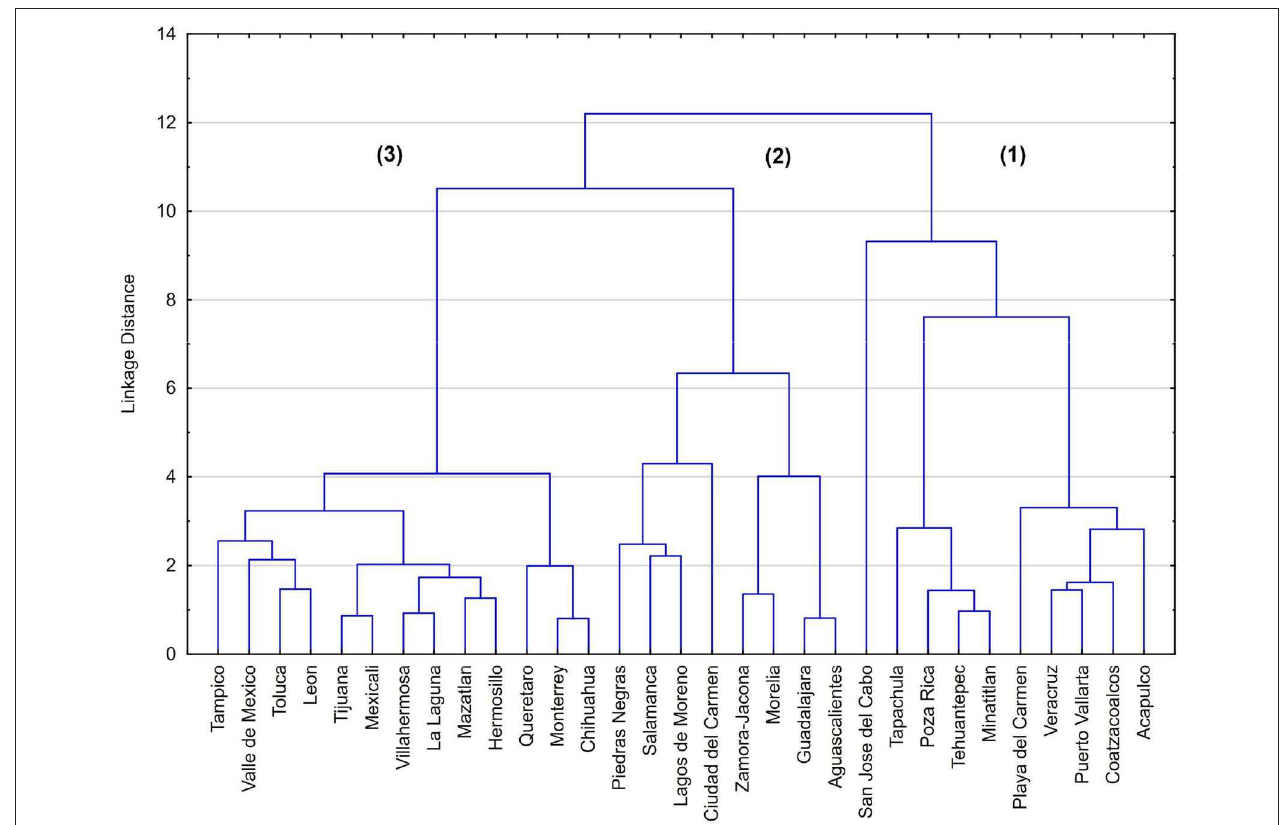
FIGURE 4 | Cluster analysis for the largest, more developed cities (PC1 > 0), based on the PC2–PC9 indices. Ward’s amalgamation method and Euclidean distances were used.